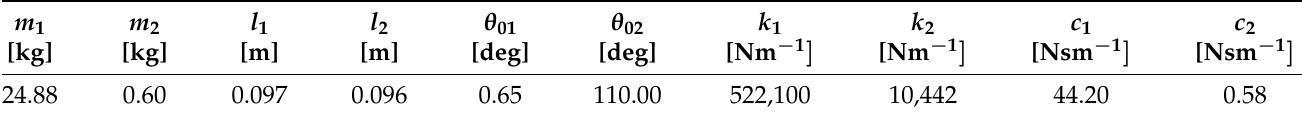
Table 3. Optimized values of the design variables.